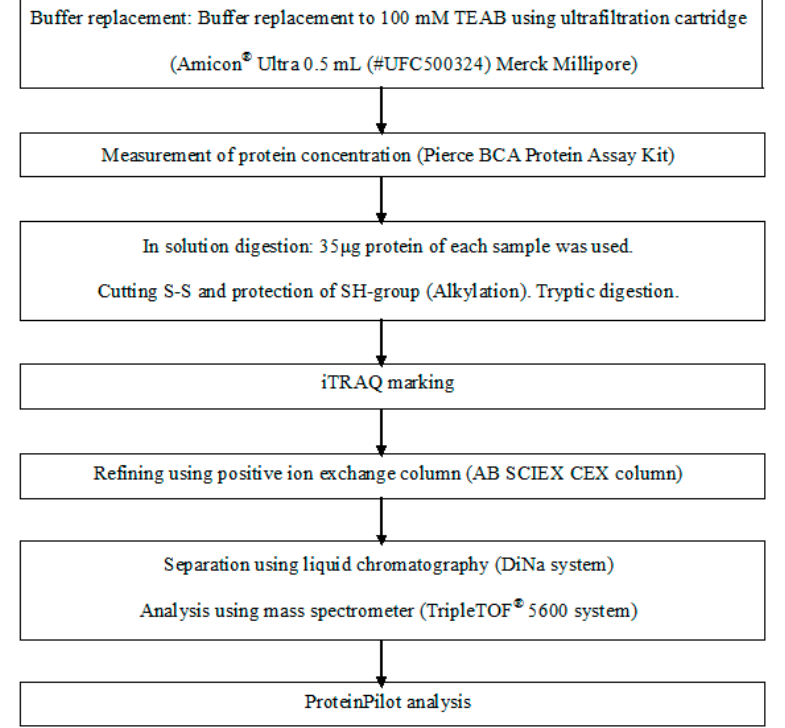
Figure 2. iTRAQ proteomic analysis. iTRAQ: Isobaric Tag for Relative and Absolute